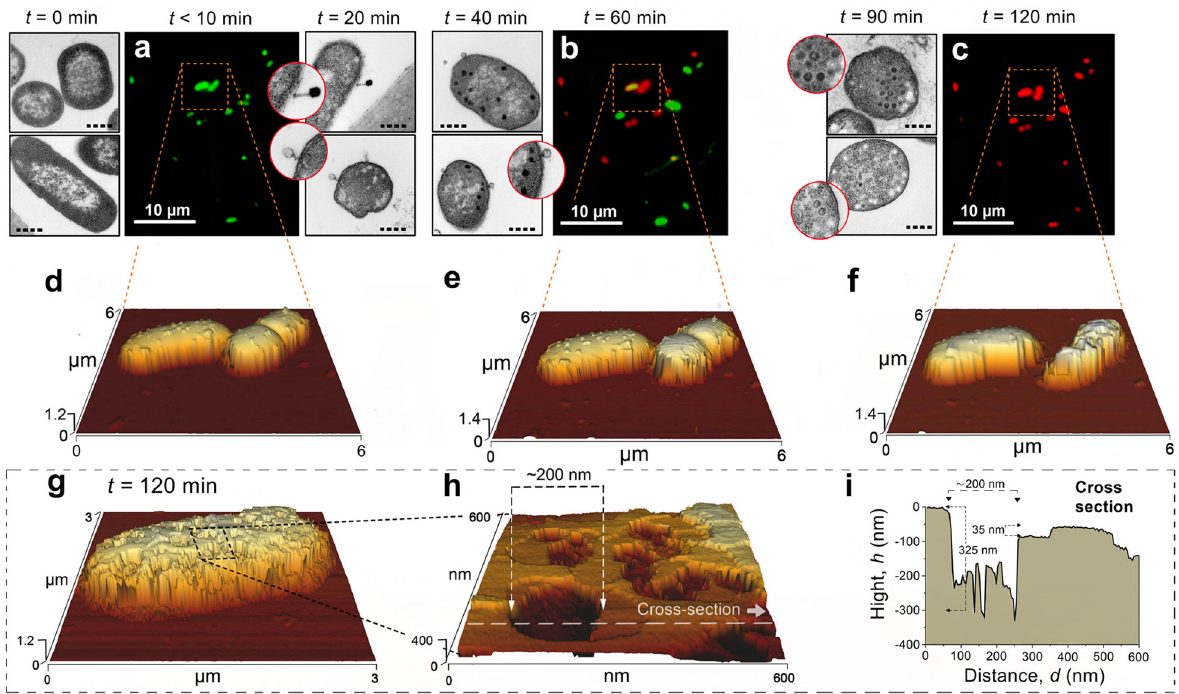
Fig. 2 Changes in the physiological properties of E. coli cells following phage infection. a – c In situ fl uorescence and d – h concomitant AFM images following the infection of bio fi lm-forming E. coli cells by T4 phages. i Cross-sectional analysis of the corresponding AFM nanotopography image ( h ). Epi fl uorescence images of “ live ” (green) and “ dead ” (red) cells, as well as the corresponding AFM scans, which were captured immediately after T4 infection ( t < 10 min) as well as 60 min and 120 min following T4 addition. “ Live ” and “ dead ” bacteria were identi fi ed by staining the cells with SYTO 9 and PI, respectively (see also Supplementary Fig. 1). Complementary microtome slices of E. coli cells on a polycarbonate surface covered with LBL were captured by TEM before T4 addition as well as 10, 20, 40, and 90 min after T4 were added. Black circles within the TEM inserts ( t = 40, 90 min) indicate the presence of T4 virions inside the cells. TEM scale bar was 1 µm (dashed line) for the low magni fi cation and 0.4 µm (circles) for the larger magni fi cations. Similar images were captured from 12 other cells at 5 individual